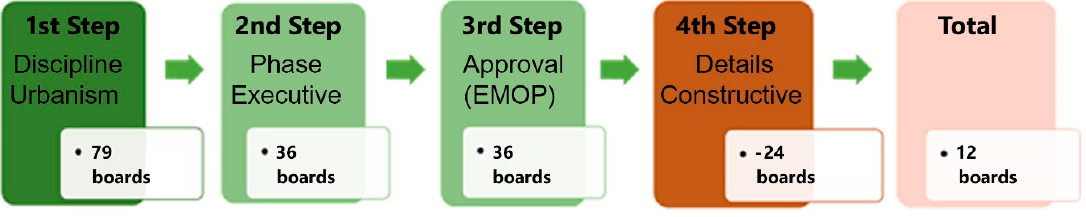
Figure 3. Sample selection steps.